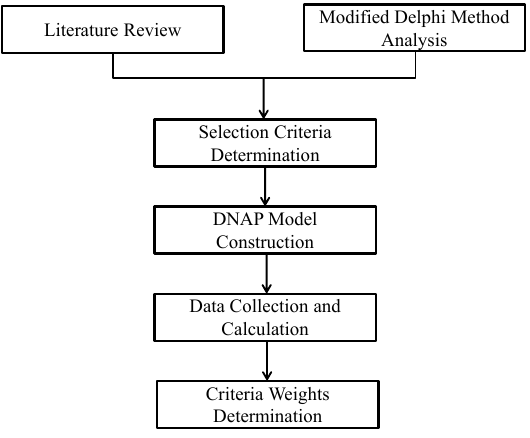
Figure 1. Our research process.